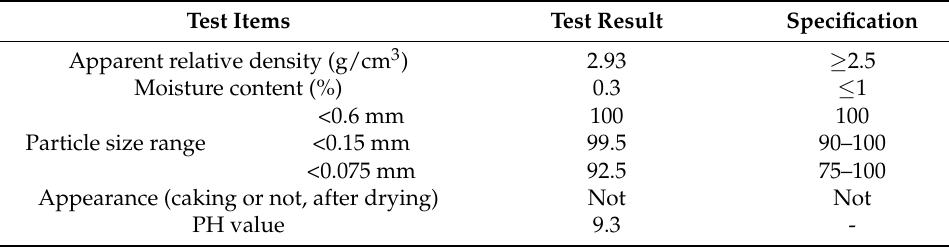
Figure 2. Pretreated phosphorus tailing micro-powder and Lee’s pycnometer. ( a ) Pretreated phos- phorus tailing micro-powder; ( b ) Lee’s pycnometer. Table 1. Main technical indicators of phosphorus tailing powder.